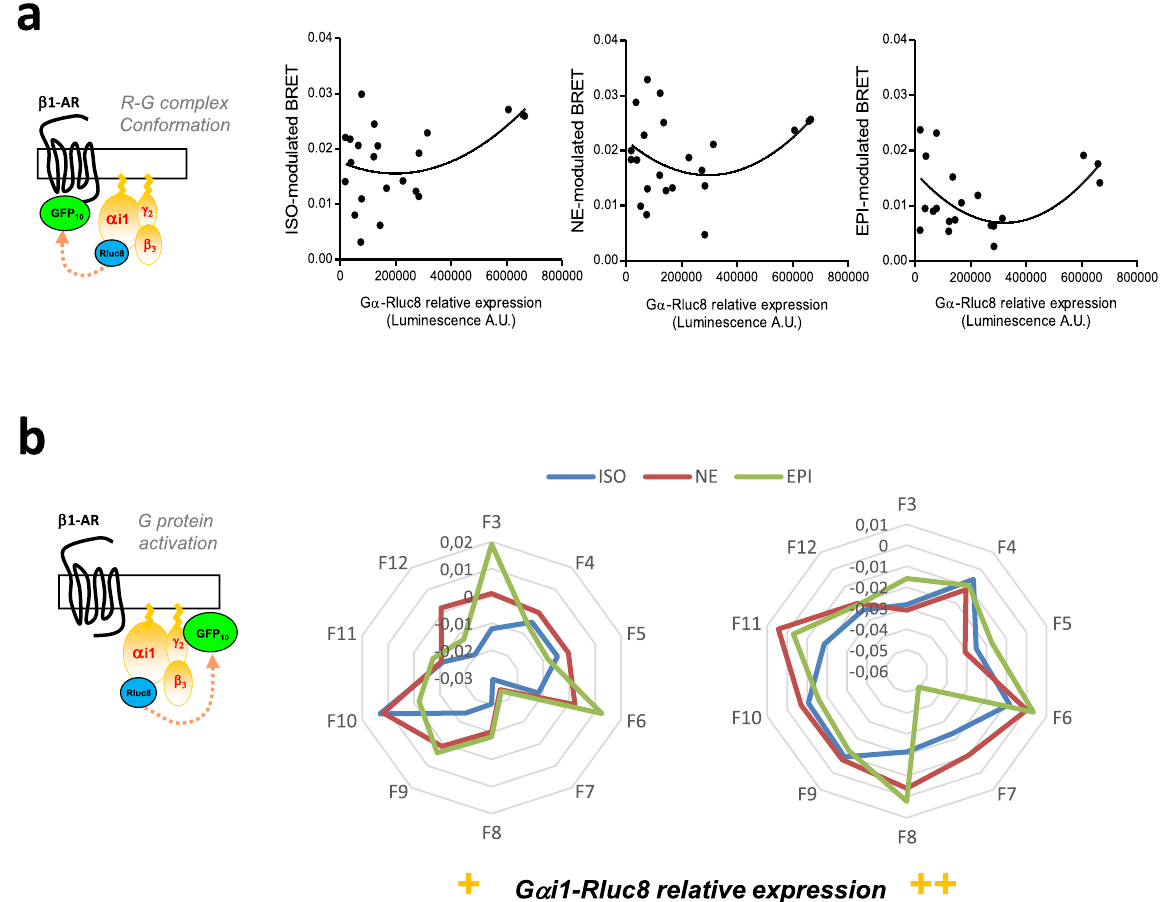
Figure 5. Influence of the G α stoichiometry on β -adrenergic agonist responses through different membrane Receptor-G protein populations. ( a ) Receptor-G protein complexes conformations assessed by BRET in HEK293T cells co-expressing β 1AR-GFP10 receptor and different expression levels of G α i1-Rluc8 in presence of fixed G γ 2 and G β 3 untagged subunits. Cells were then stimulated or not for 1 min with 10 µ M of the indicated ligands (ISO, NE or EPI). Results are expressed as the difference in BRET signals measured in presence and absence of ligand and are representative of four independent experiments. Curves were generated using a polynomial quadratic model. ( b ) G protein activation measured in sucrose fractions by BRET in HEK293T cells, co-expressing HA- β 1AR receptor and different expression levels of G α i1-Rluc8 in presence of fixed GFP10-G γ 2 and G β 3 untagged subunits, and processed for raft purification. Results are expressed as the difference in BRET signals measured in presence and absence of ligand and plotted in the wheel diagram from the different sucrose fractions (F3 to F12). They are representative of three independent